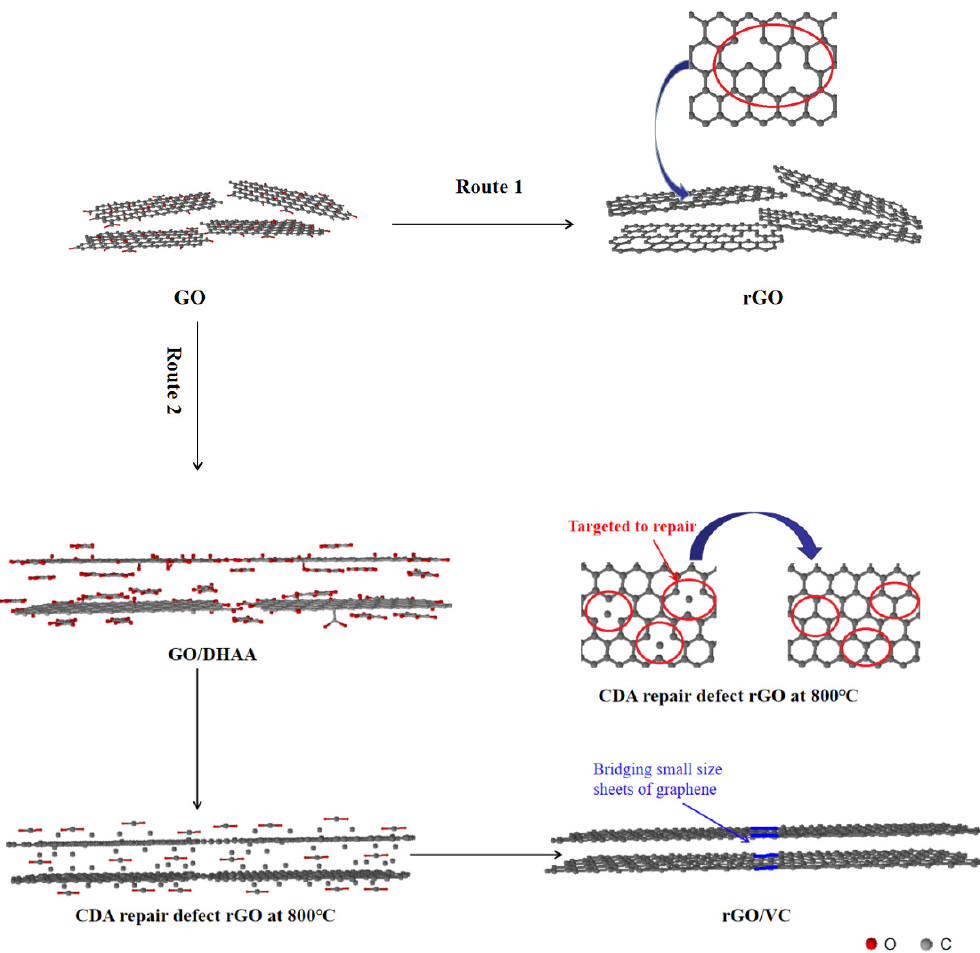
Figure 5. Mechanism of carbonized dehydroascorbic acid (CDA) for targeted repair of graphene defects and bridge connection of graphene sheets with small size.